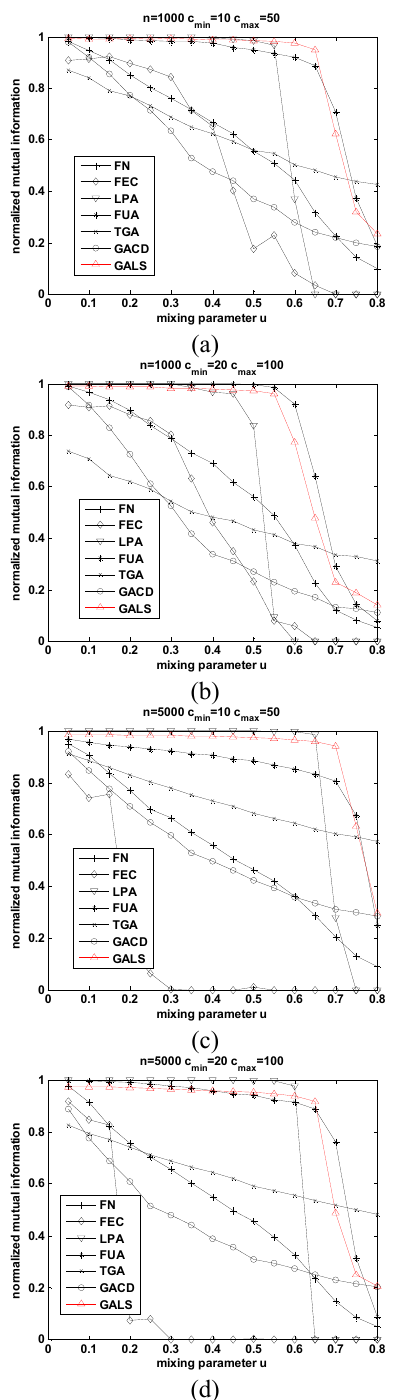
Fig. 7. (Color online) Compare GALS with FN, FEC, LPA, FUA, TGA and GACD in terms of NMI accuracy on the LFR benchmark networks. (a) Comparison on small networks with small communities ( n = 1000, c min = 10, c max = 50). (b)